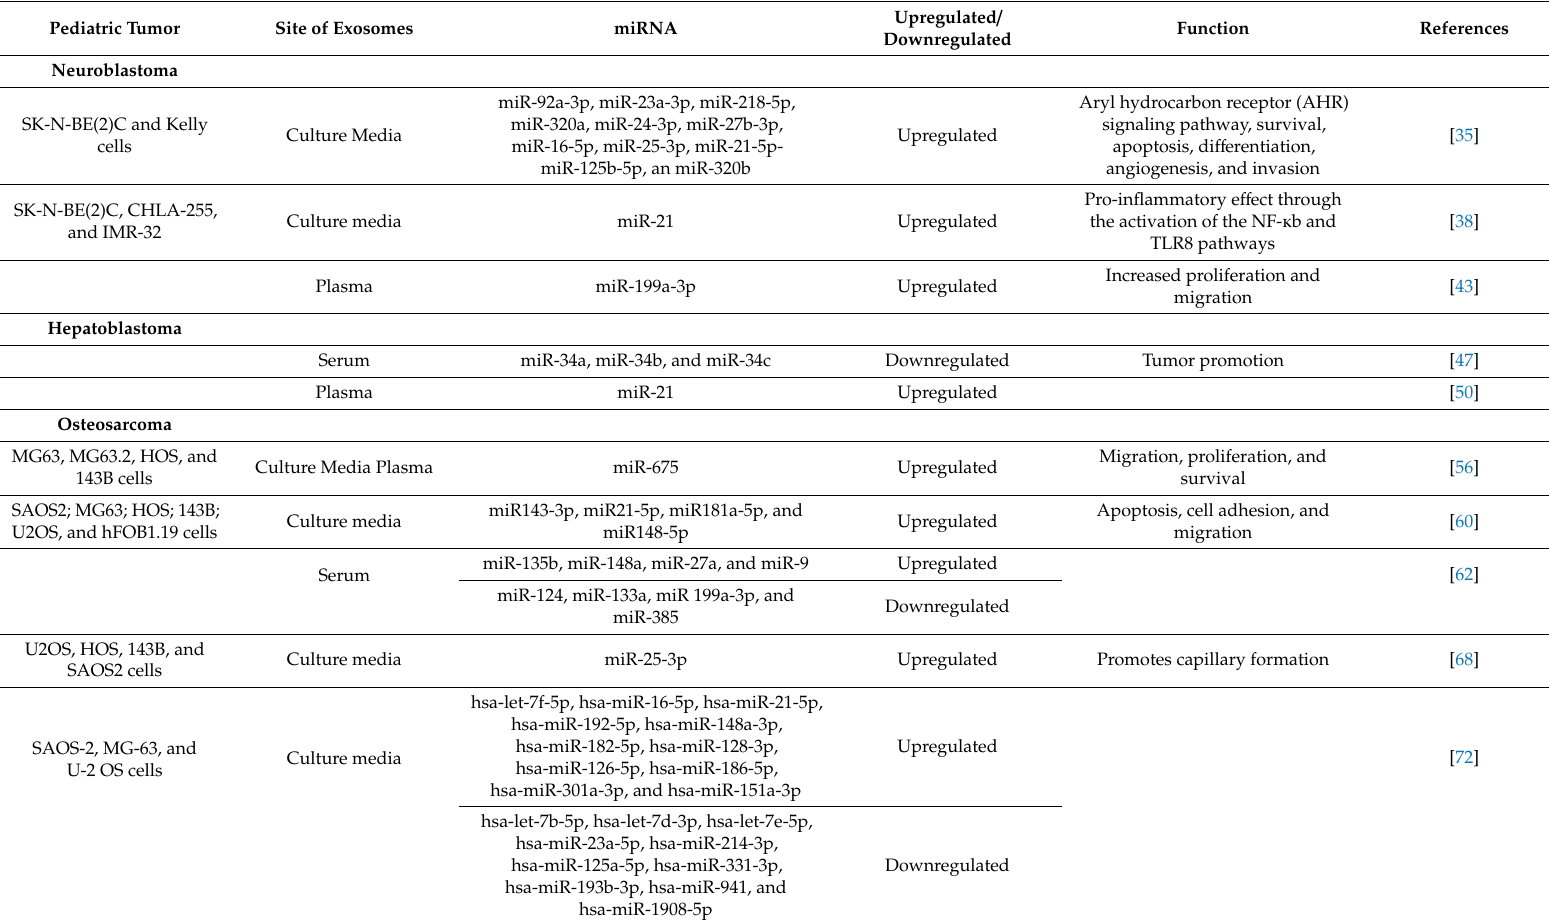
Table 1. MicroRNAs (MiRNAs) contained in pediatric tumor